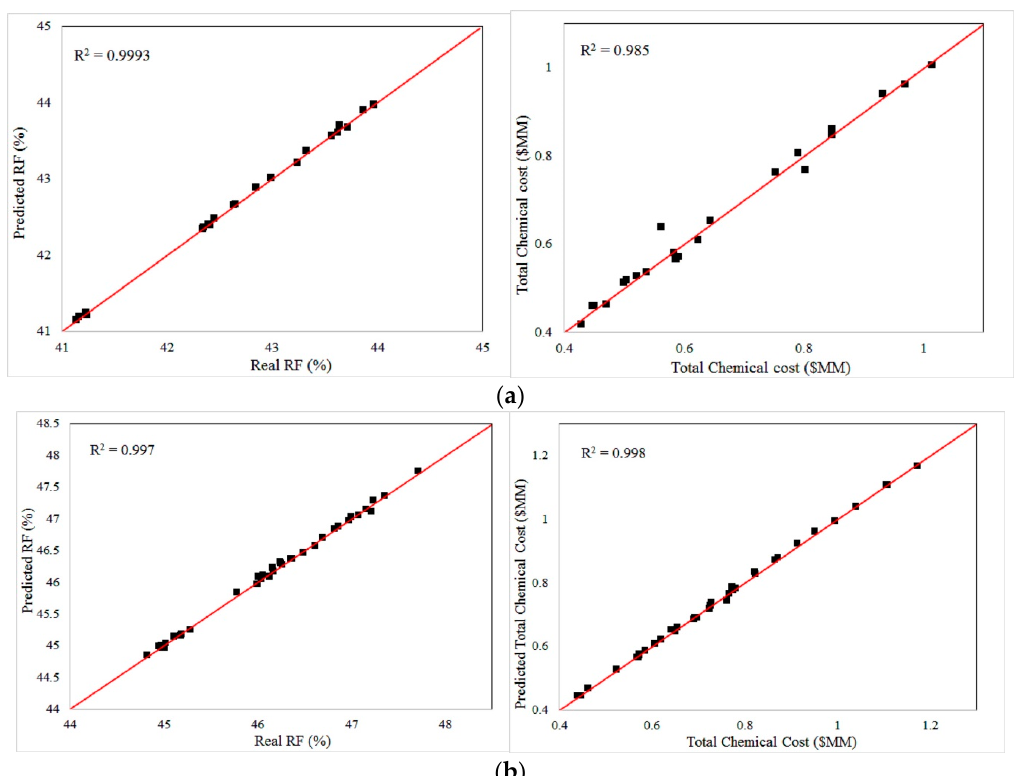
Figure 10. Estimated results of the oil recovery factor and total chemical expenses by the RSM: ( a ) W ‐ ASP ‐ W; ( b ) W ‐ ASP ‐ P ‐ W.